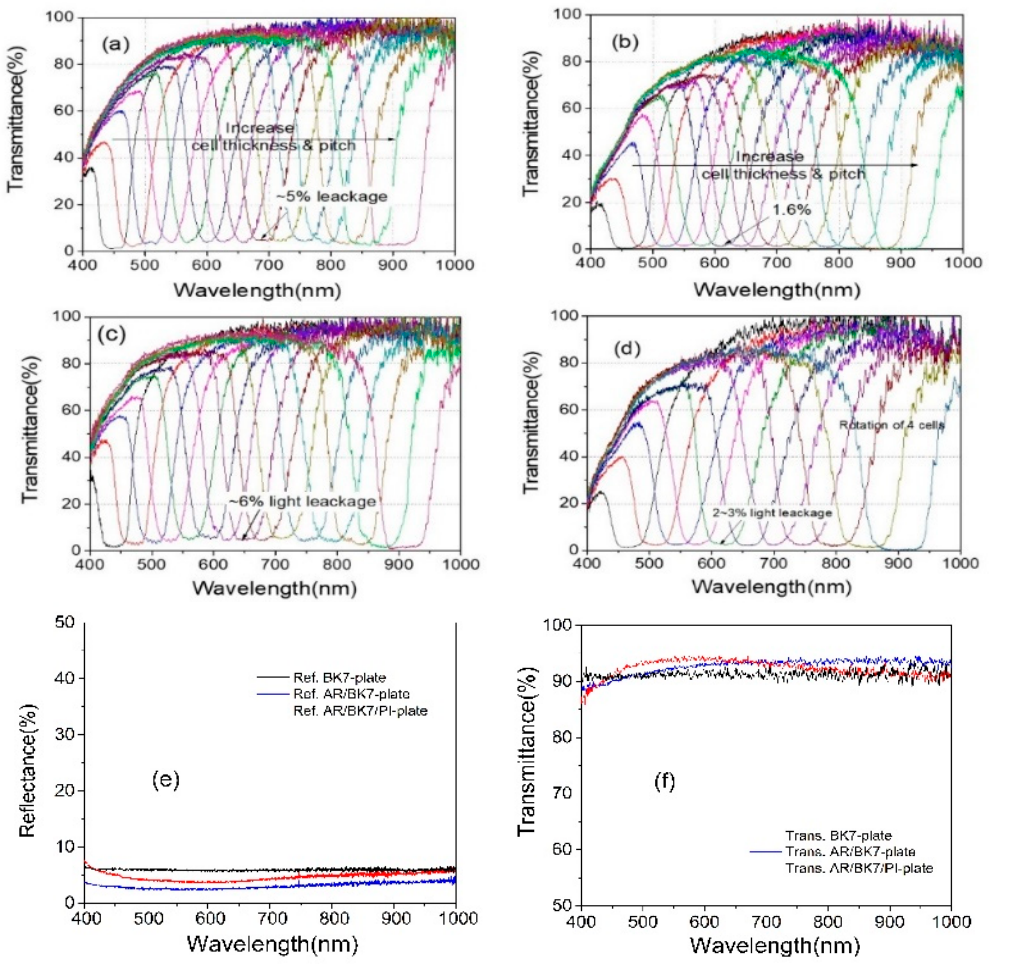
Figure 6. Spectra of continuous tuning notch filter system in Path 1 of Figure 4 ( a ) via lateral movement of one notch filter system and ( b ) via lateral movement of two notch filter systems. Notch filter spectra ( c ) via rotation of one notch filter system or ( d ) via rotation of two notch filter systems. Data are shown in a low density to distinguish one by one easily. ( e ) Reflectance of BK7 plate, AR/BK7 plate, and AR/BK7/PI plate. ( f ) Transmittance of BK7 plate, AR/BK7 plate, and AR/BK7/PI plate, respectively.